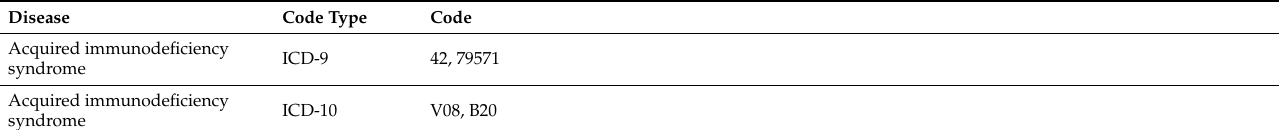
Table A2. ICD code set for CCI